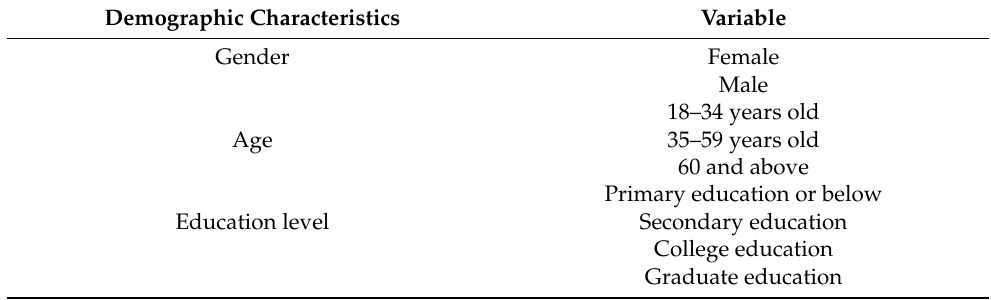
Table 4. The variables of different demographic characteristics and their corresponding scores.